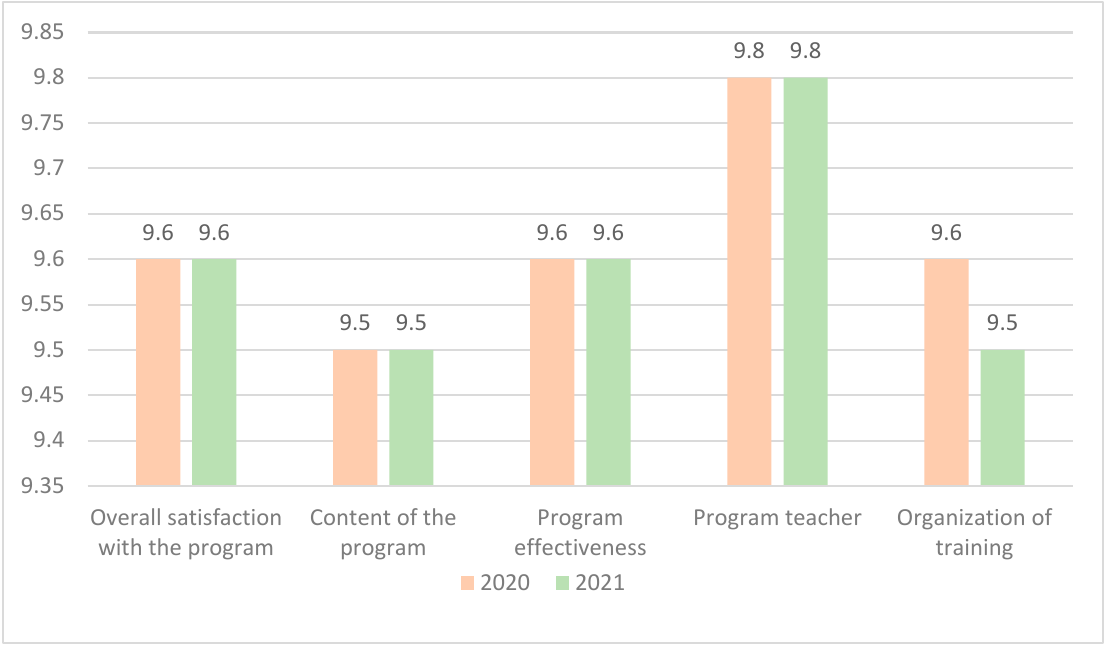
Figure 1. The degree of satisfaction of the participants on the example of the program “Team of Leaders” for 2020–2021 (level 1).